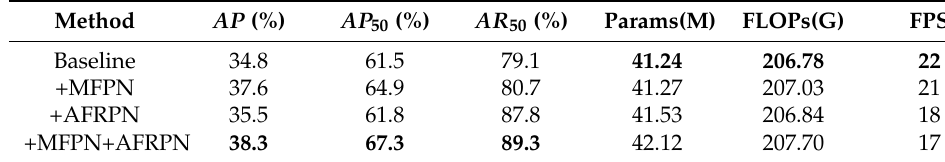
Table 4. Comparison of the performance with and without the proposed module.